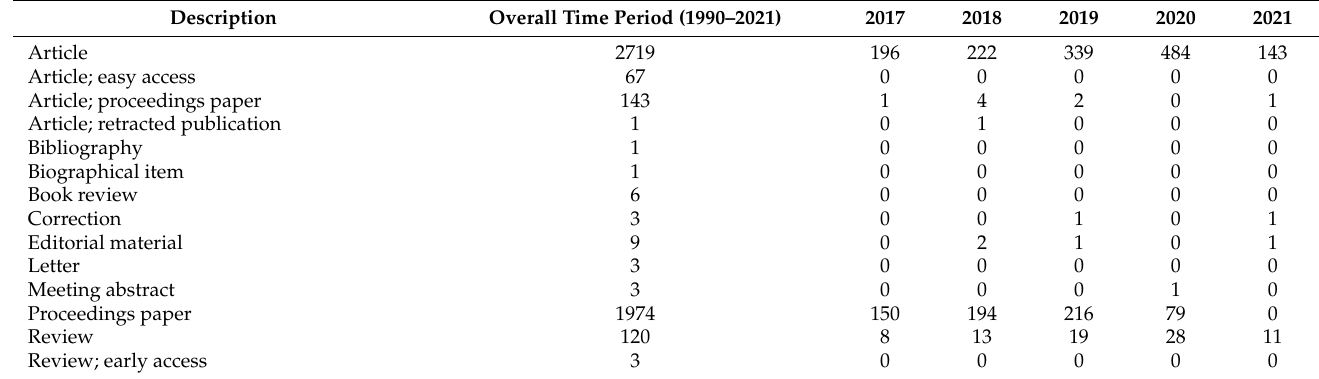
Table 2. Document type, overall period, and per